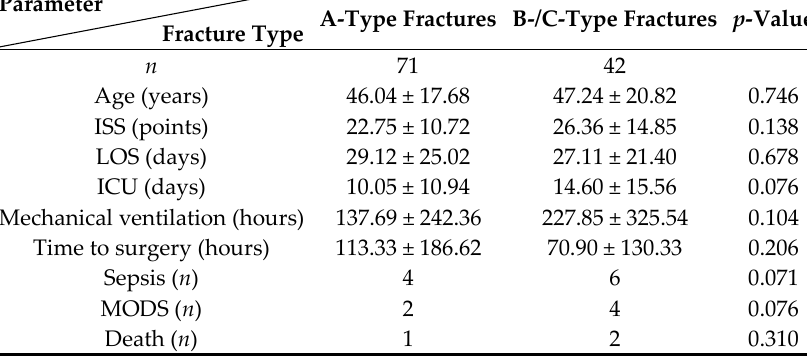
Table 9. Stratification analysis (ANOVA and chi-square test) of the fracture type (A-type vs. B-/C-type fractures).